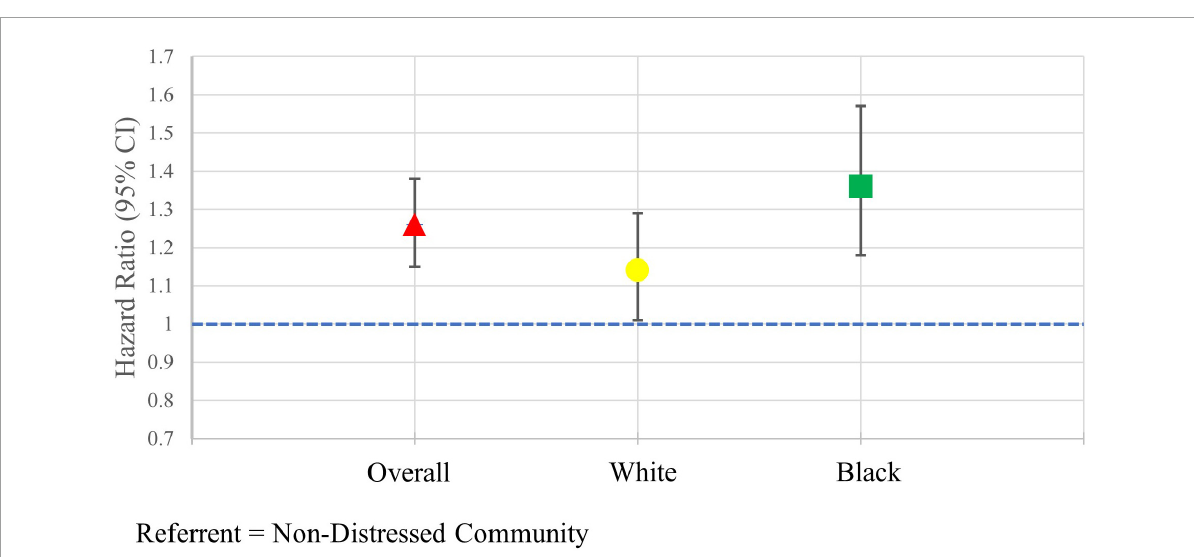
in amputation risks among different PAD populations